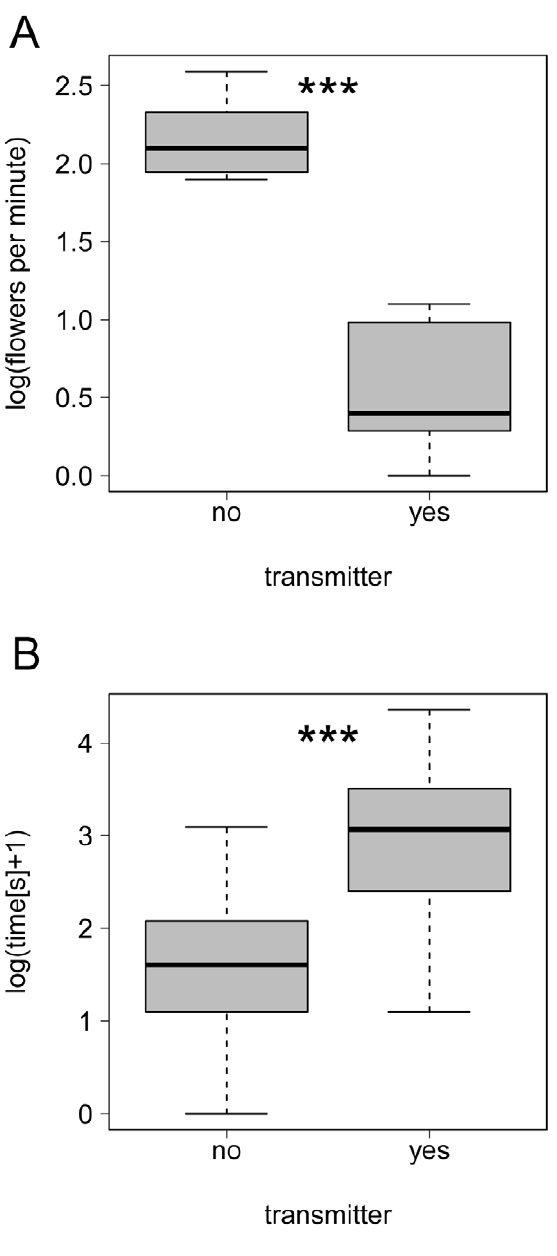
Figure 2. Effect of transmitter attachment (yes/no) on foraging behavior of Bombusterrestris . ( a ) Visitation rates (number of Phacelia flower heads visited per minute), and ( b ) time on flowers (foraging time spent on individual Phacelia flower heads). *** indicates significant differences between groups at p , 0.001 (see text).